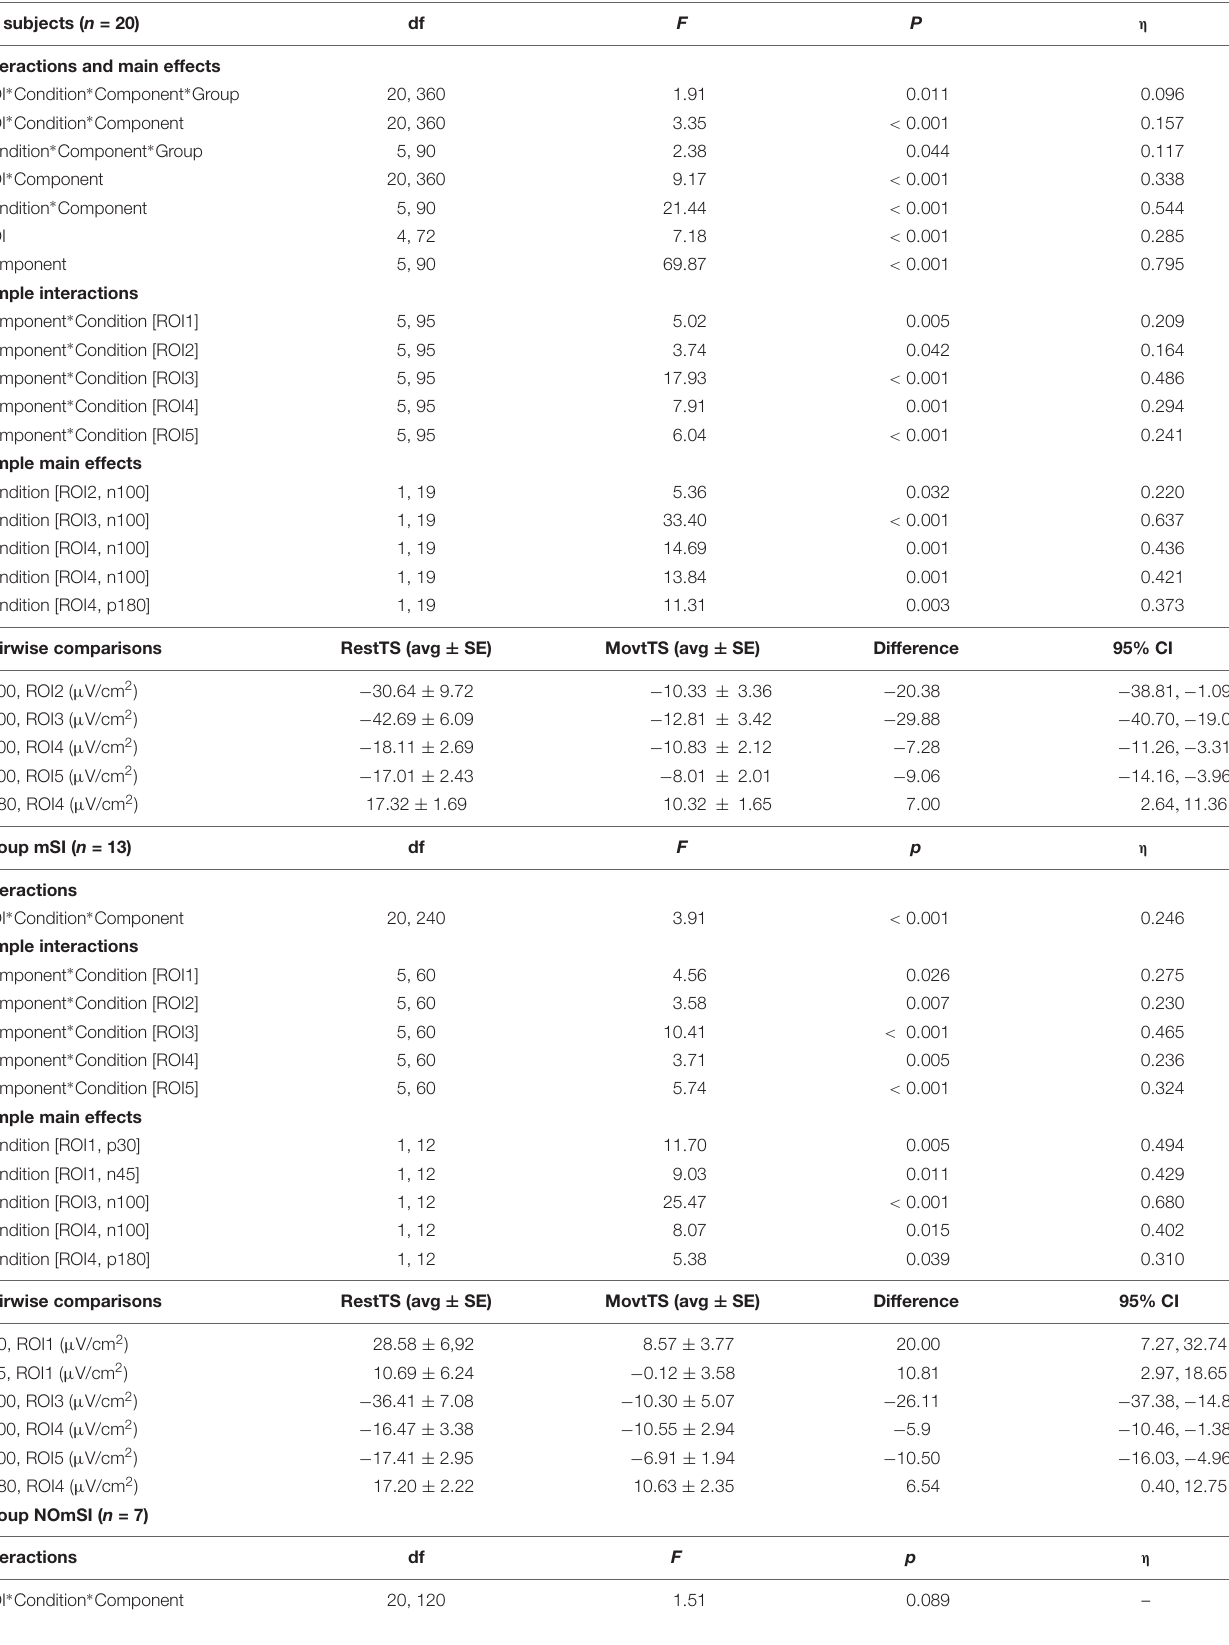
TABLE 2 | Movement onset and mSI related modulation of TEPs amplitude – Four-way ANOVA: significant effects and interactions. All subjects ( n =